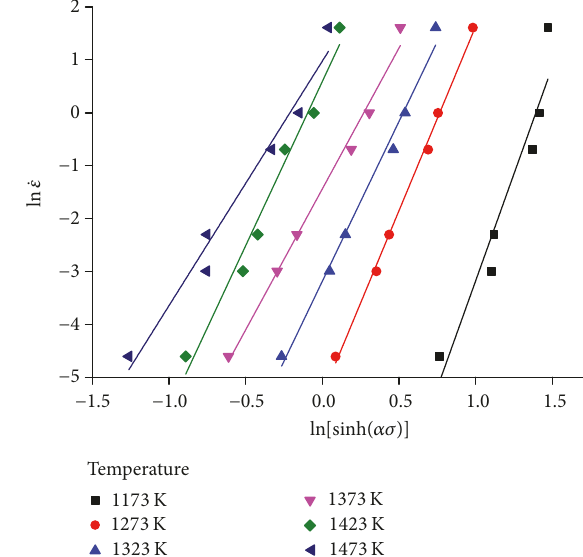
Figure 5: Relationship between ln 𝜎 and ln ̇𝜀 .